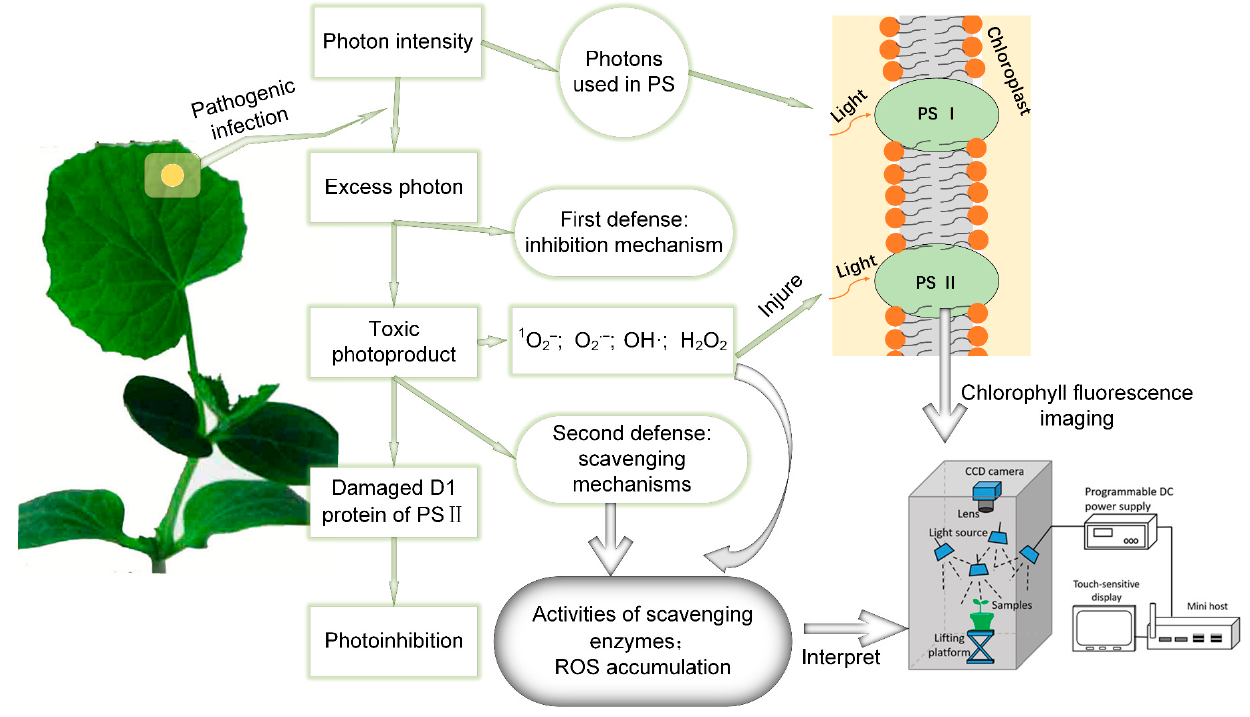
Figure 1. Reactive oxygen species production scavenging system and schematic overview of the analytical procedure for disease detection. (Singlet oxygen: 1 O 2 − , Superoxide: O 2 • − , Hydroxyl: OH·, Hydrogen peroxide: H 2 O 2 , Photosystem: PS, ROS: Reactive oxygen species).